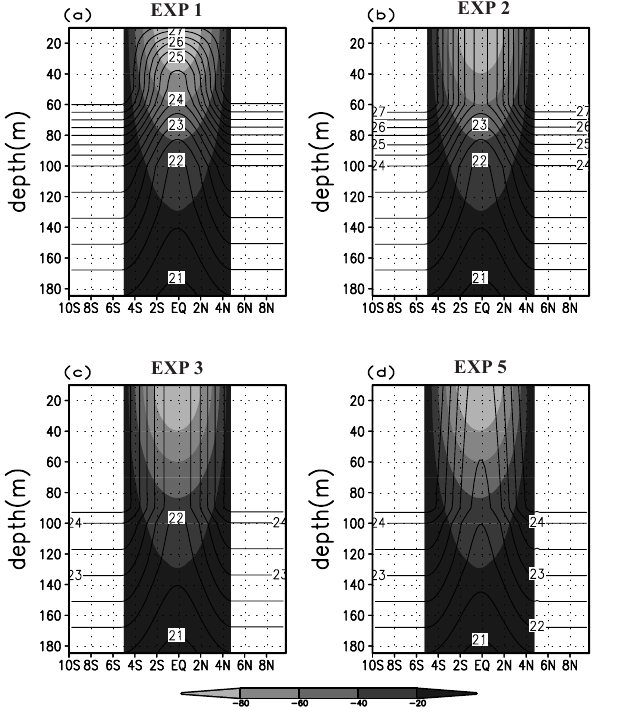
Fig. 1. Depth-latitude sections of zonally uniform horizontal ve- locity (shaded) and temperature field (contour) used as the initial condition for: (a) EXP 1, (b) EXP 2, (c) EXP 3 and (d) EXP 5. Contour interval is 0.5 ◦ C for temperature and 20cm/s for velocity.